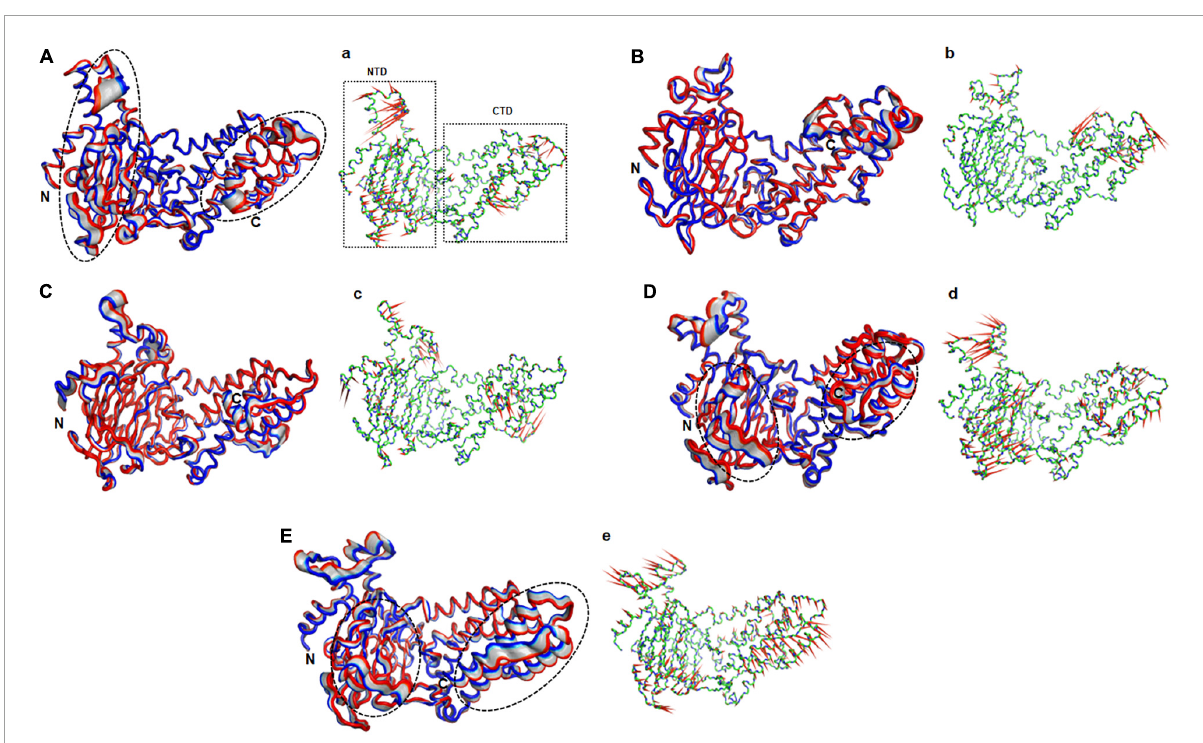
FIGURE5 Essential motions analyses of WT and MT proteins. (A) WT, (B) E234P, (C) R316Q, (D) R322Q, and (E) C392D. Motions in both NTD and CTD were highlighted in black dotted circles. Red to blue regions indicated minimum to maximum motions, respectively. Panels (a–e) showed corresponding porcupine structures. Length and direction of cones in the porcupine structures represented magnitude and direction of the motions. NTD, N-terminal domain; CTD, C-terminal